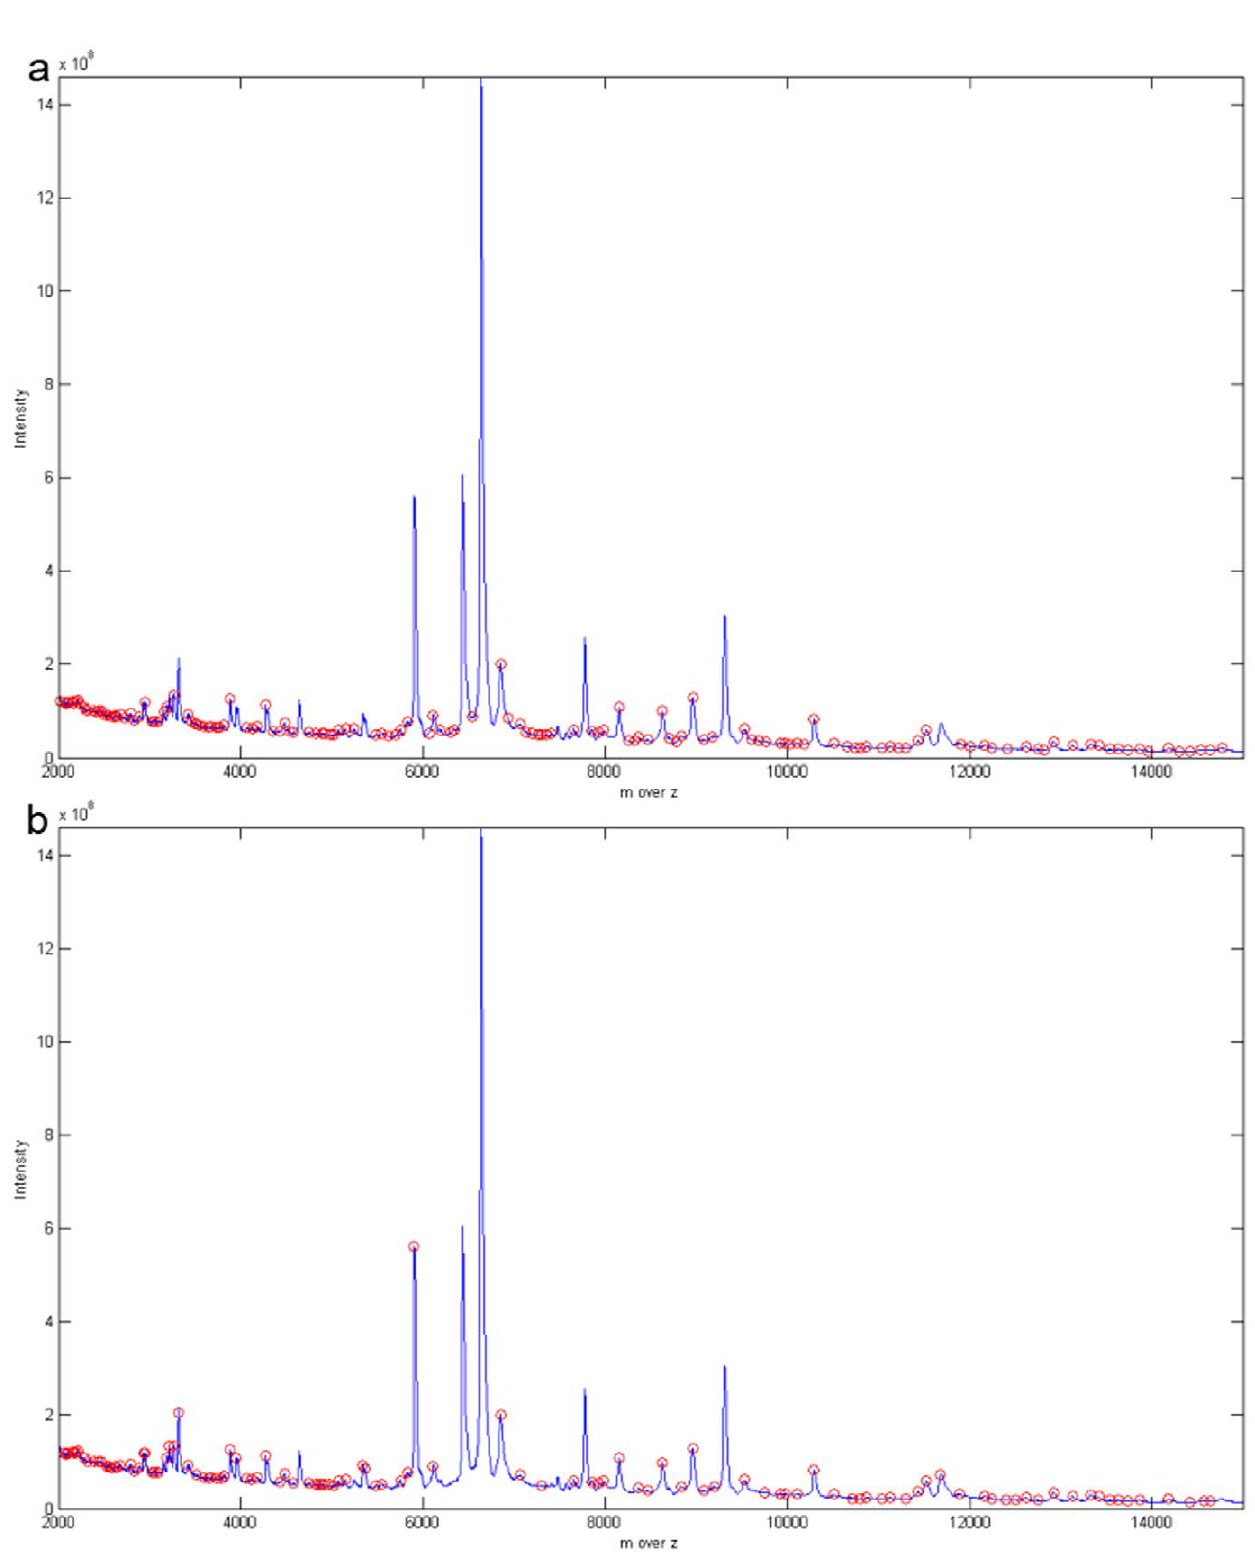
Figure 7. Peaks detected by PRO1 and PRO2. (a) The ovarian cancer dataset preprocessed by PRO1. PRO1 missed the three largest peaks. PRO1 detected 145 peaks in the whole region. (b) The ovarian cancer dataset preprocessed by PRO2. PRO2 misses the two largest peaks. PRO2 detected 114 peaks in the whole region.